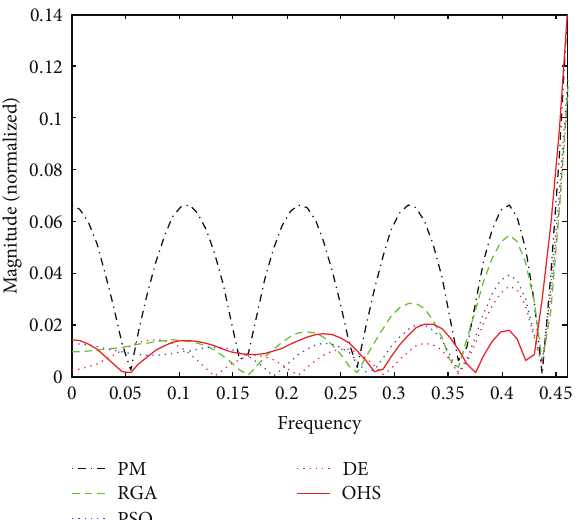
Figure 10: Normalized plots for the FIR BP filter of order